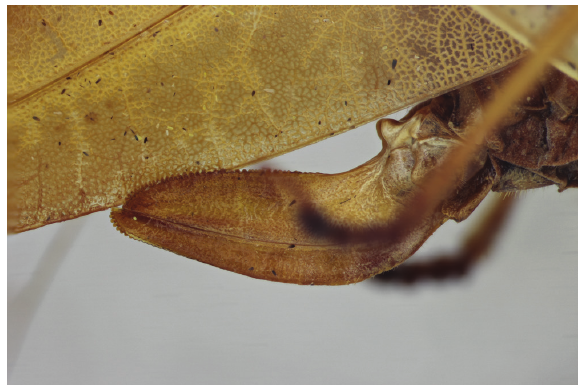
Figure 1. Lateral view on ovipositor of female Dapanera sp. Uganda (NHML).